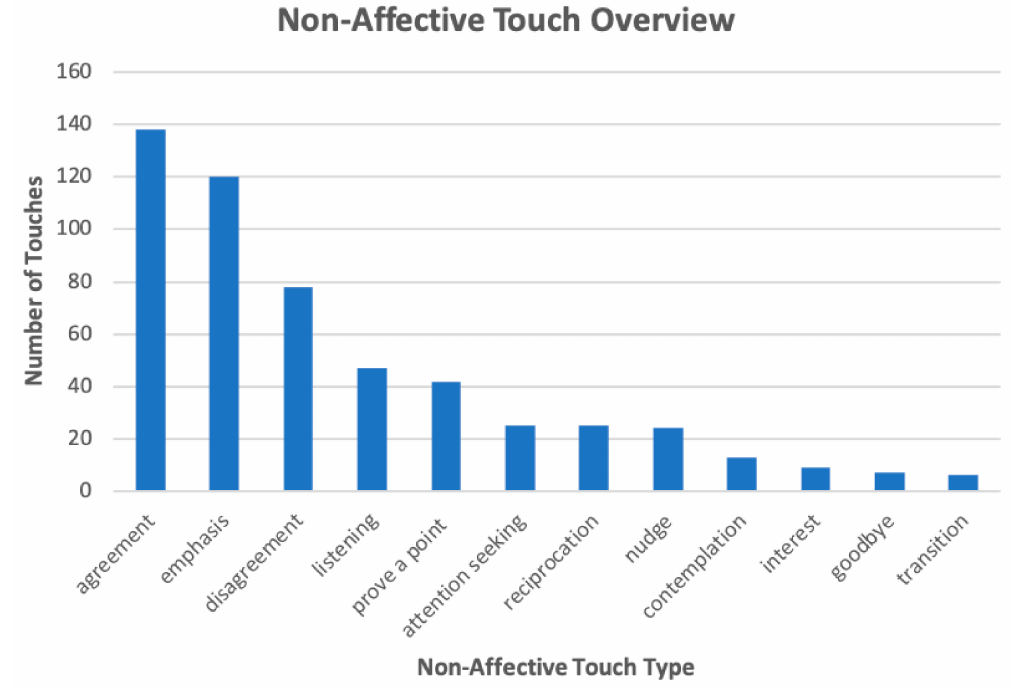
Figure 4. Distribution of Touches in Non-Affective